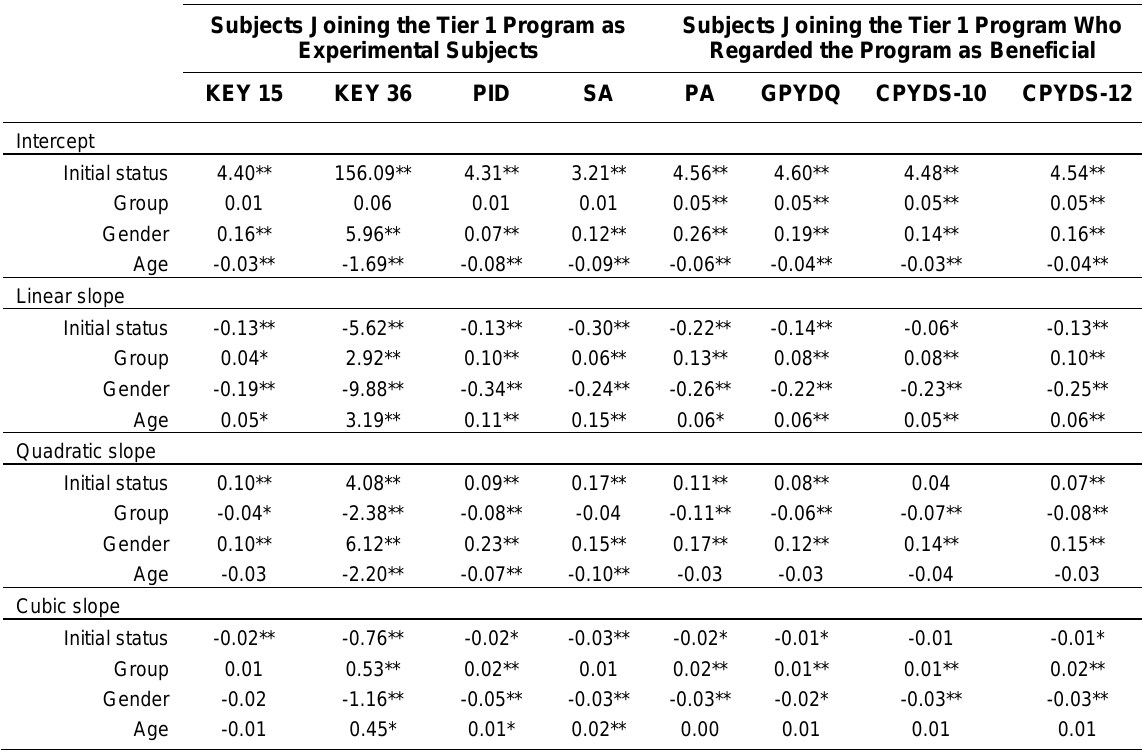
Results of Growth Curve Models for Indicators Derived from the CPYDS and School Adjustment